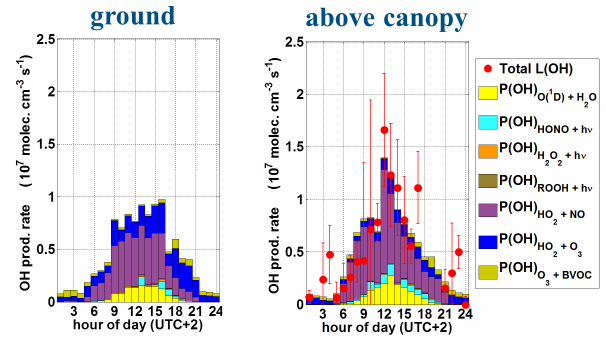
Figure 10. Average on-ground (left panel, 27–30 July) and above- canopy (right panel, 1–8 August) diurnal OH production. The whiskers indicate the variability of the total loss rate, calculated from total OH reactivity and hydroxyl radical measurement using LIF